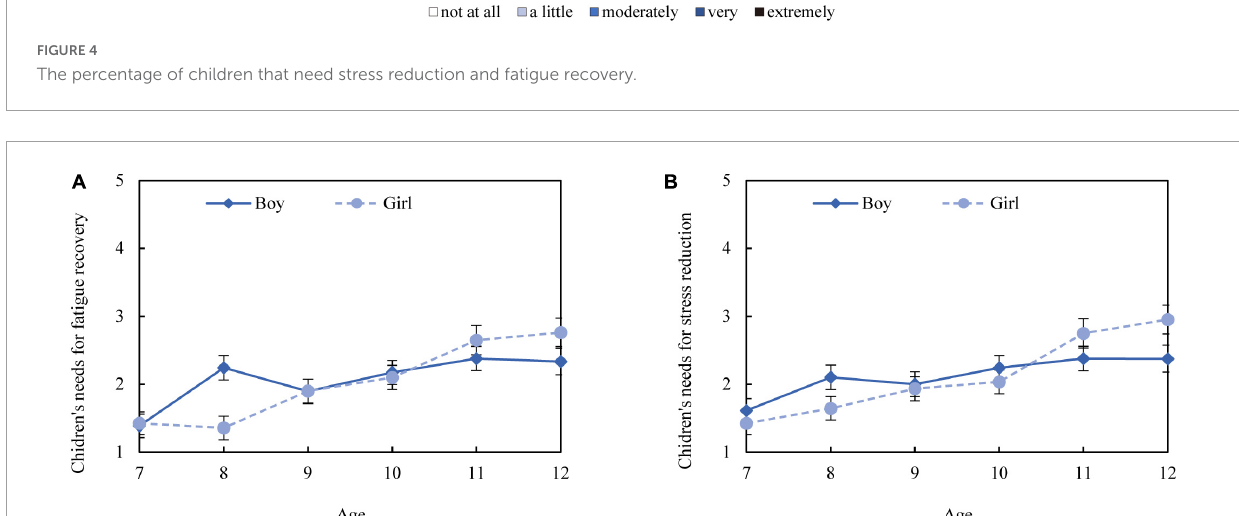
FIGURE5 Difference in restoration needs for fatigue recovery (A) and stress reduction (B) among gender and